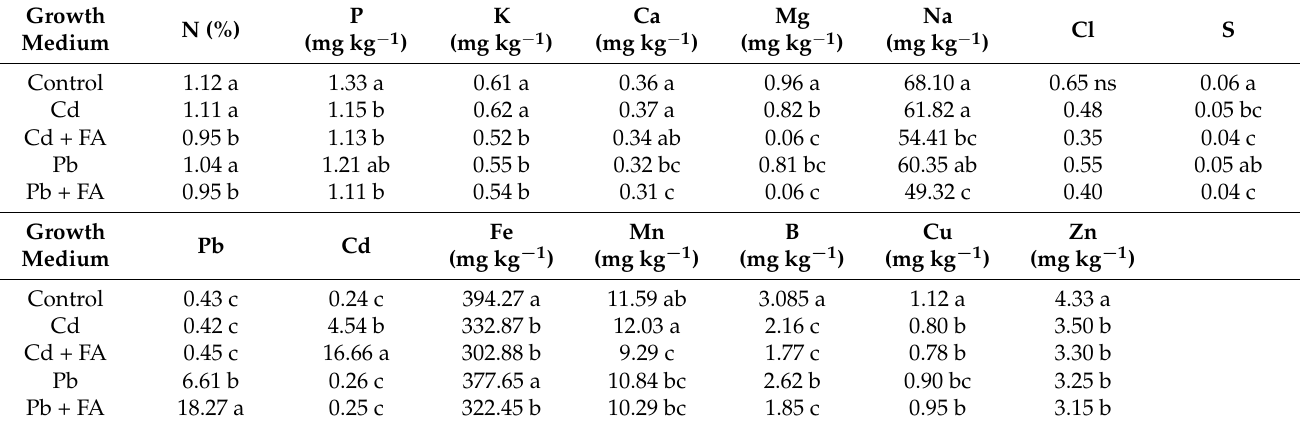
Table 3. The root part macro and micro element analysis results of Tagetes eracta .